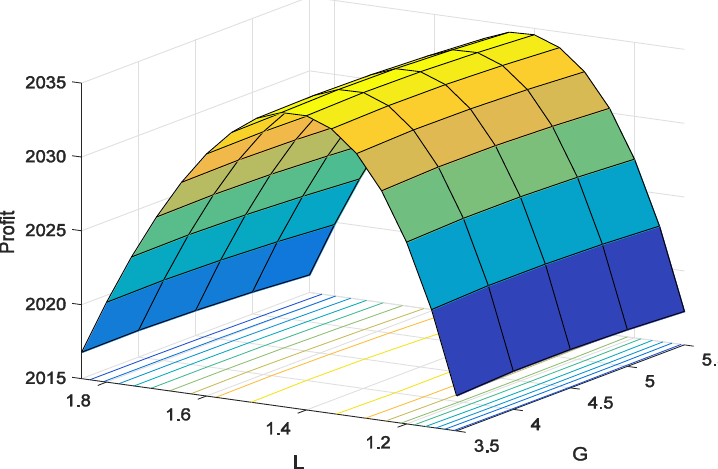
Figure 3. Profit function with regard to G and L.